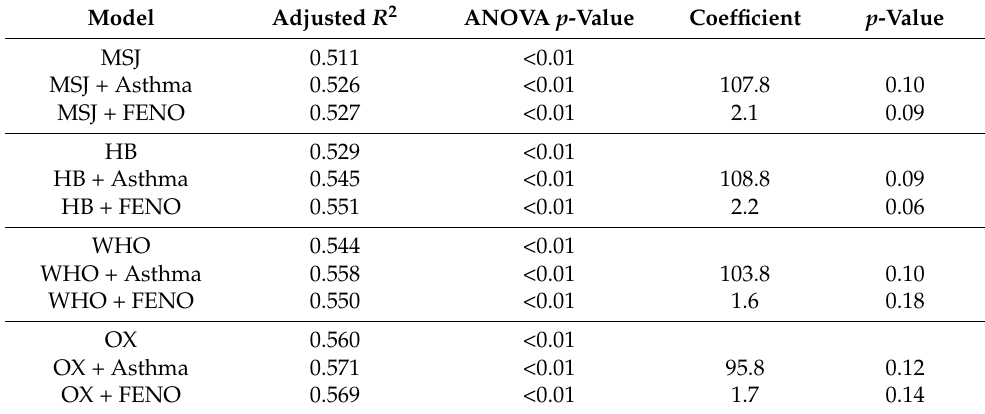
Figure 2. Differences in Resting Energy Expenditure and Correlations with Immune Cells. ( A ) Asthmatic have elevated REE compared to controls, presented as percentage-predicted REE using four validated REE predicted equations. REE (percentage-predicted to MSJ) positively correlated with ( B ) WBCs ( r = 0.34, p < 0.01) and ( C ) Neutrophils ( r = 0.32, p = 0.01). Relationships were similar for HB, WHO, and OX prediction equations. REE, resting energy expenditure; MSJ, Mifflin–St. Jeor; HB, Harris–Benedict; WHO, World Health Organization; OX, Oxford equations; percentage-predicted REE is the percentage of REE IC to REE MSJ/HB/WHO/OX . Table 4. Prediction Equation Adjustments for Asthma Status and F E NO.